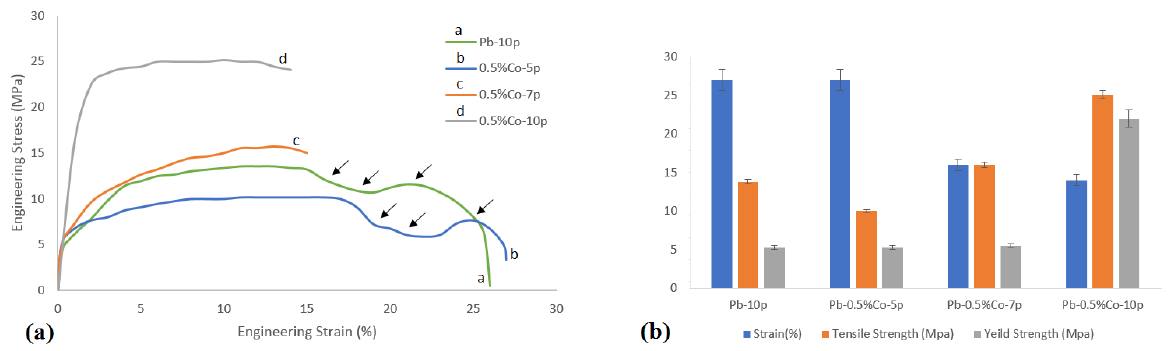
Figure 1. ( a ) Stress–strain curves and ( b ) yield strength, tensile strength, and strain of various composites.